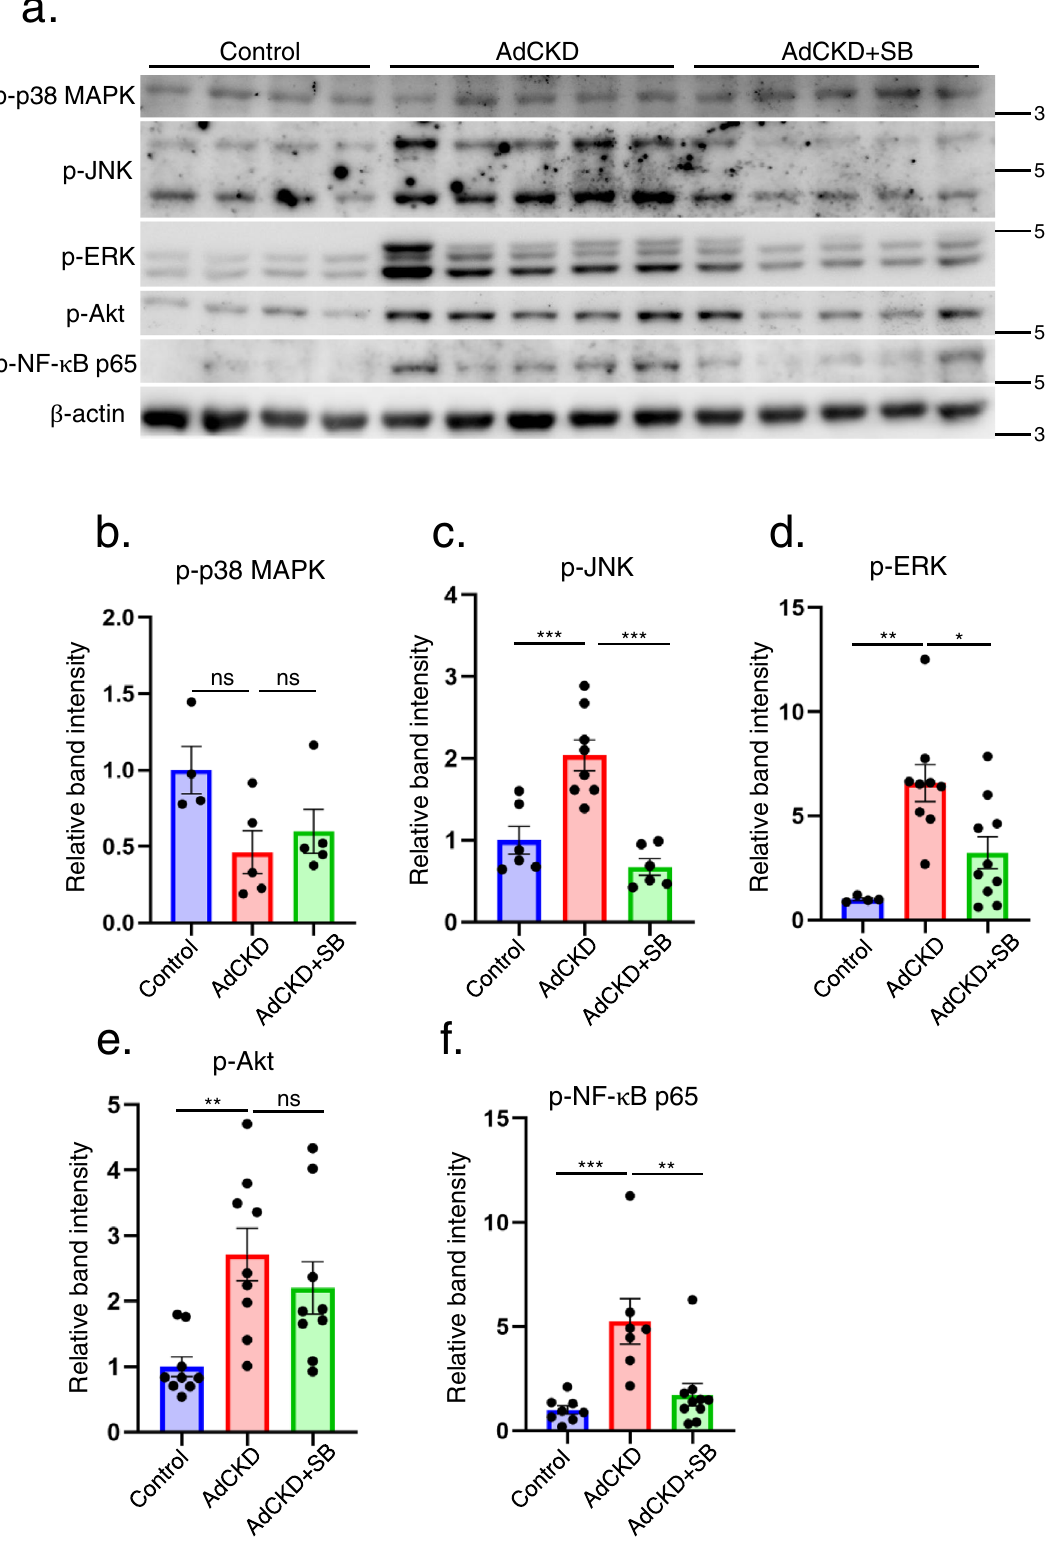
Figure 4. SB reduces the phosphorylation of JNK, ERK, and NF-κB p65 in the kidneys of AdCKD mice. ( a ) Immunoblots of the respective groups are shown. Band intensities of ( b ) phopho-p38 MAPK (p-p38 MAPK), ( c ) phospho-JNK (p-JNK), ( d ) phospho-ERK (p-ERK), ( e ) phospho-Akt (p-Akt), and ( f ) phospho-NF-κB p65 (p-NF-κB p65) were quantified and adjusted to the intensities of the internal control molecule β-actin (n = 4–10). Mice in the AdCKD + SB group showed decreased levels of p-JNK, p-ERK, and p-NF-κB p65 compared with mice in the AdCKD group. * p < 0.05; ** p < 0.01; *** p < 0.001; ns, not significant. Each bar represents mean ± SEM. SB, sodium